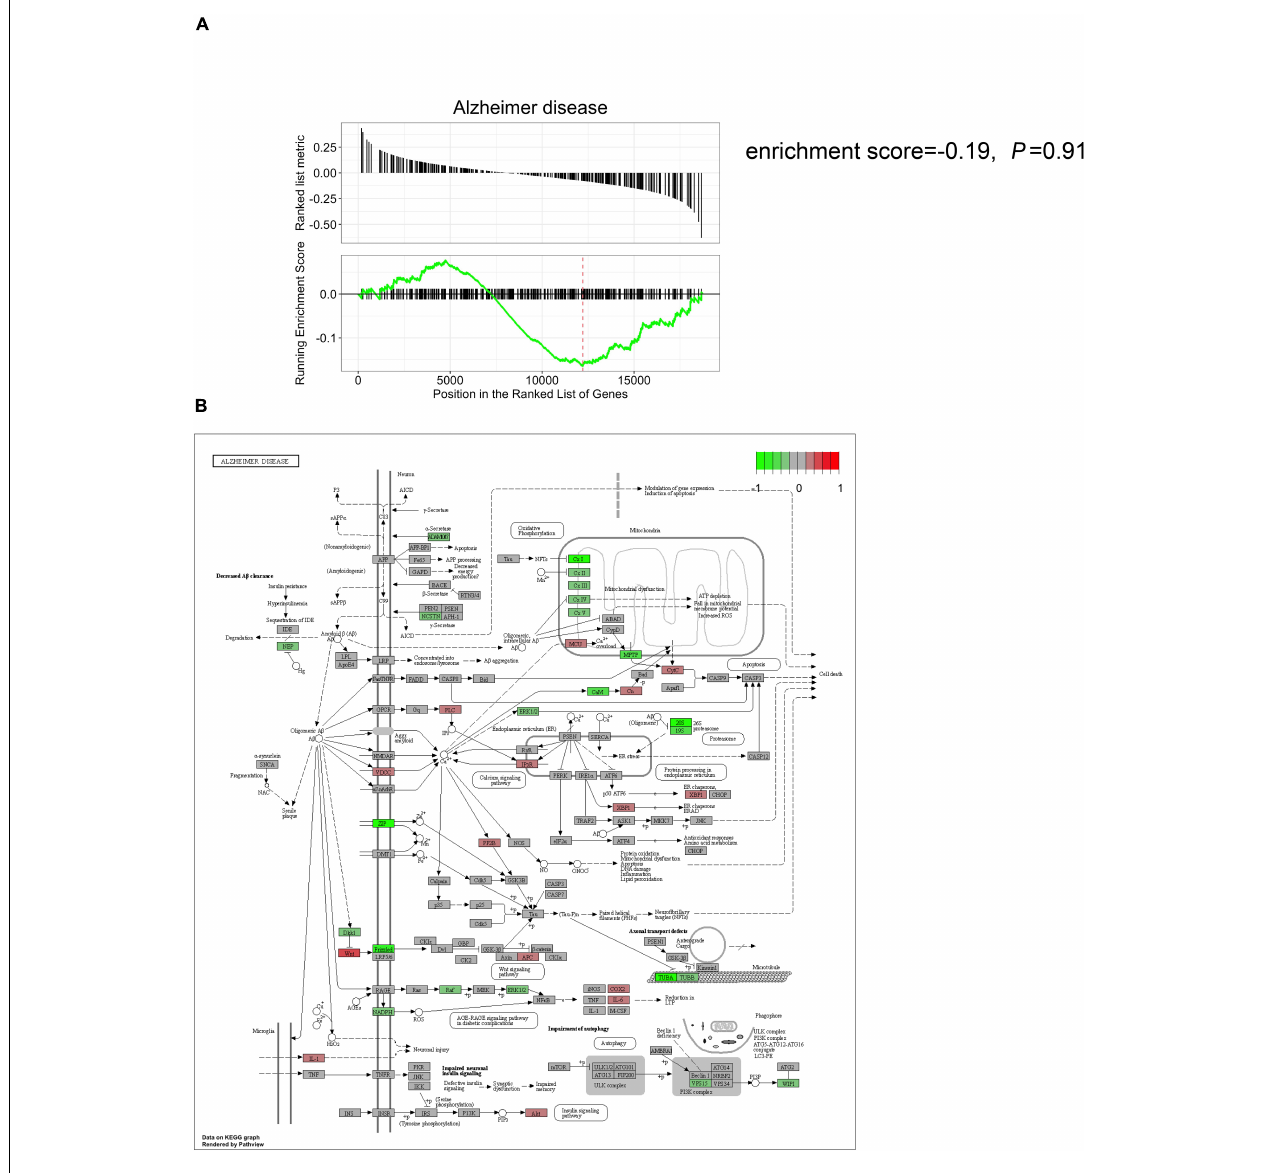
FIGURE 4 | Comparison of the hippocampal gene expression pattern in POCD animal models against the classical AD signaling pathway. (A) Gene set enrichment analysis showed that the classical AD signaling pathway is not significantly dysregulated in the POCD hippocampus (enrichment score = –0.19, p = 0.91). (B) KEGG mapping of the dysregulated gene expression in the hippocampus (red and green: up and downregulated in POCD,